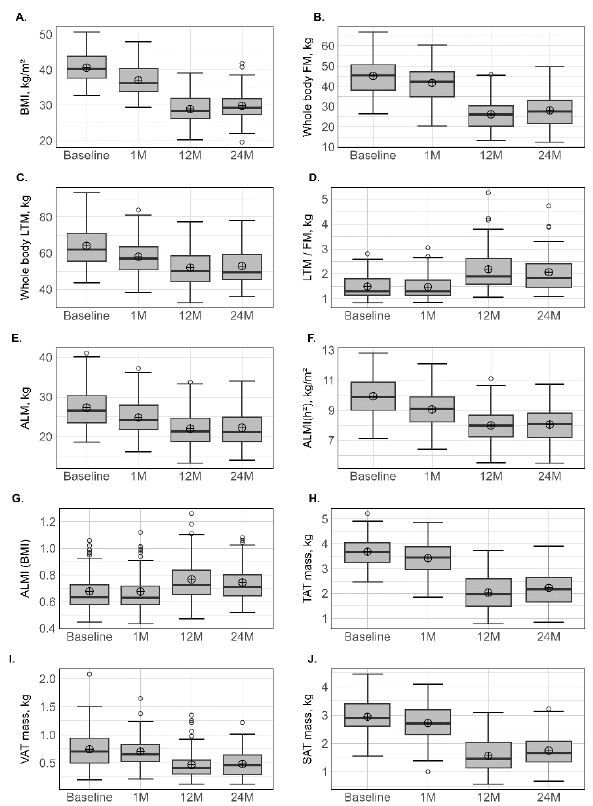
Figure 1. Variation in anthopometric and body composition parameters at different times. BMI: body mass index ( A ); FM: fat mass ( B ); LTM: lean tissue mass ( C ); LTM/FM ratio ( D ); ALM: appendicular lean mass ( E ); ALMI(h 2 ): appendicular lean mass index (height 2 ) ( F ); ALM/height 2 , ALMI(BMI) ( G ): appendicular lean mass index (BMI); TAT: total adipose tissue ( H ); VAT: visceral adipose tissue ( I ); SAT: subcutaneous adipose tissue ( J ). Lower whisker represents the smallest observation greater than or equal to lower hinge −1.5 × IQR. Upper whisker represents the largest observation less than or equal to upper hinge +1.5 × IQR. Lower and upper hinges represent, respectively, the 25 and the 75% quartile values. The open circles represent the mean value in each time. Data beyond the end of the whiskers are called outliers points and are plotted individually. IQR, interquartile range.